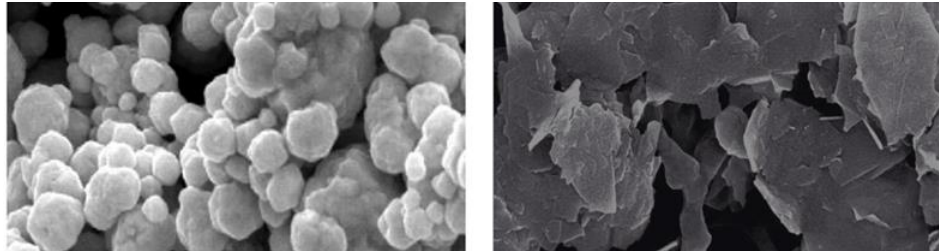
Figure 5. SEM analysis of AgNPs and GNPs.